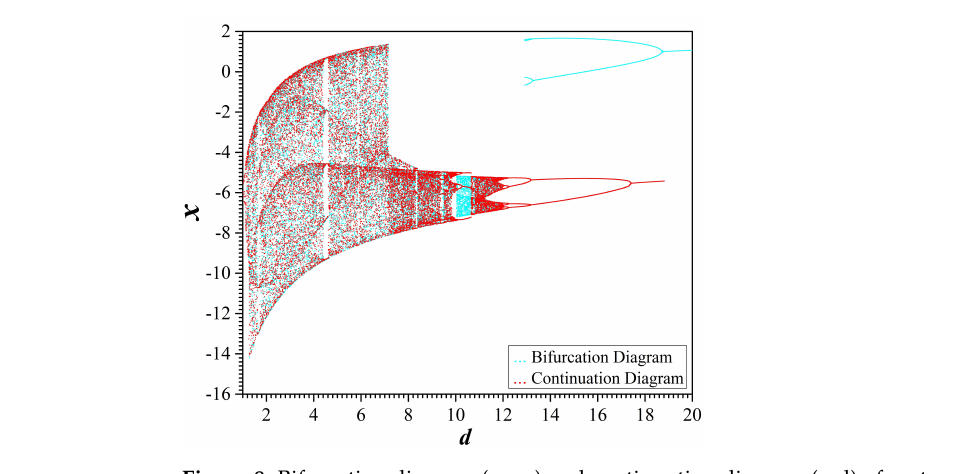
Figure 8. Bifurcation diagram (cyan) and continuation diagram (red) of system (2), when parameter d is increased, for a = 4 × 10 − 4 , b = 1, c = 3.846 × 10 − 4 and e = 1, when parameter d is increased.